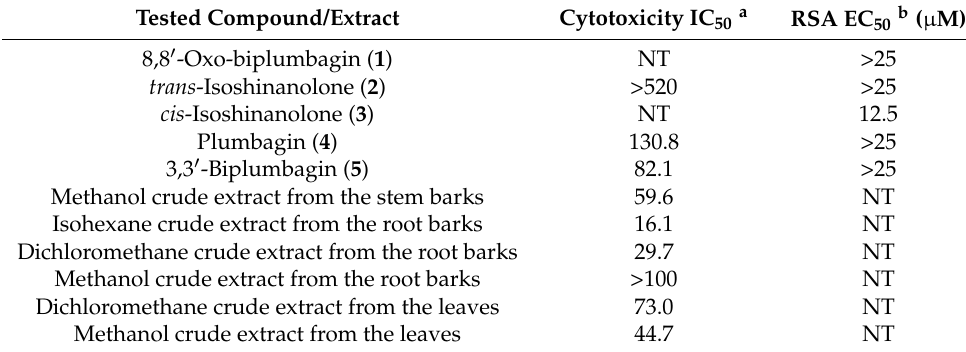
Table 2. In vitro cytotoxic and radical scavenging activities (RSA) of the crude extracts and isolated constituents from D. shimbaensis . Tested Compound/Extract Cytotoxicity IC 50 a RSA EC 50 b ( µ